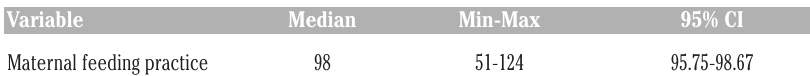
Table 2. Description of maternal feeding